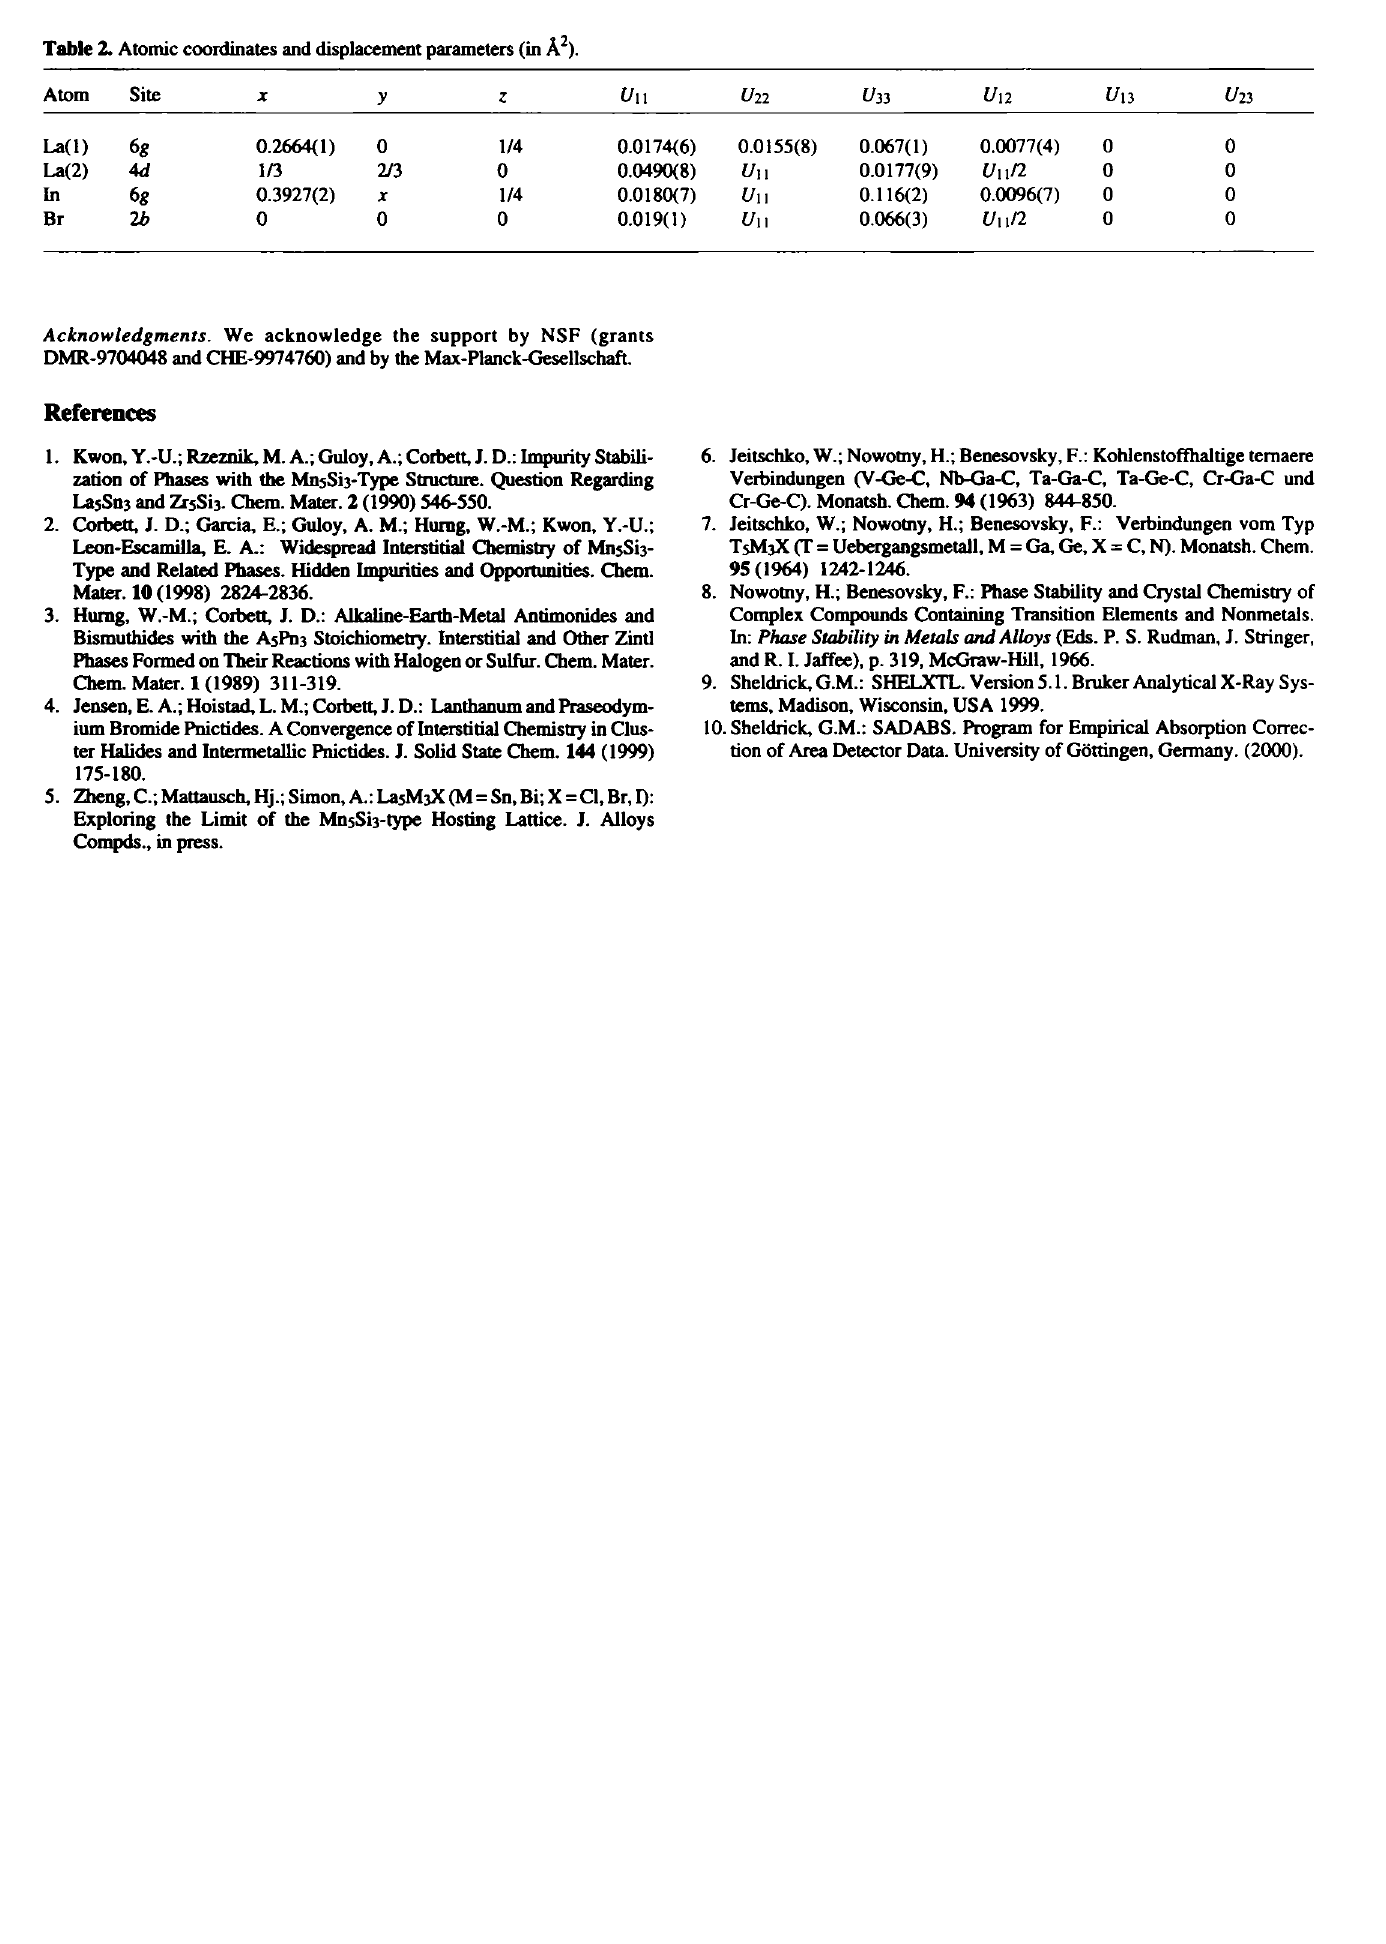
Table 2. Atomic coordinates and displacement parameters (in Â 2